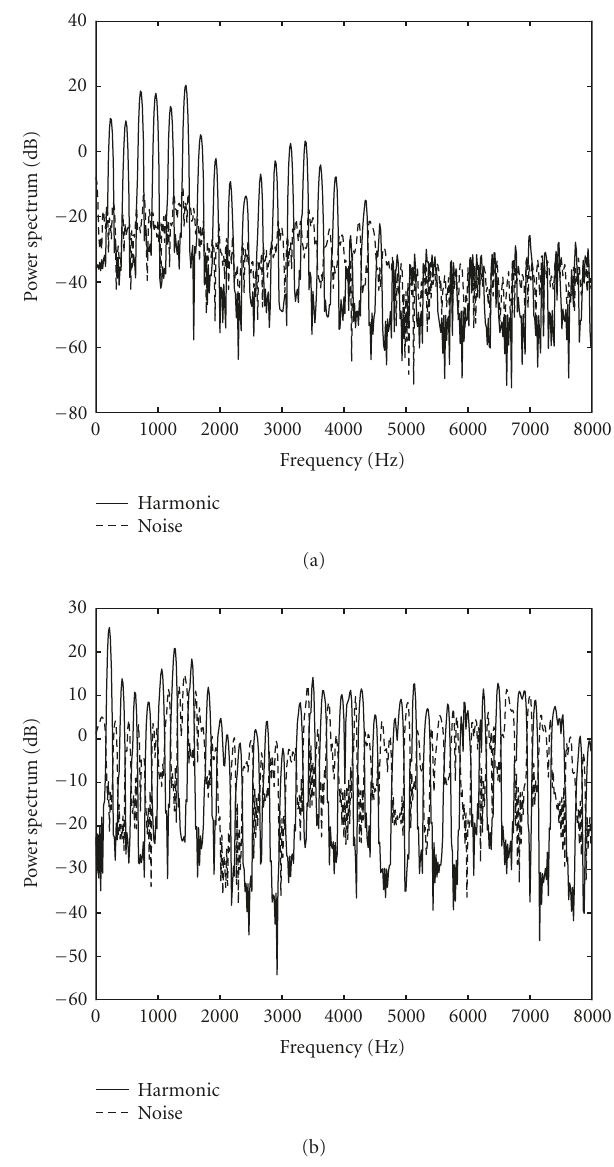
Figure 2: Power spectra of the estimated harmonic and noise com- ponents for the vowel segment /a/ corresponding to (a) a normal subject and (b) a pathologic subject.